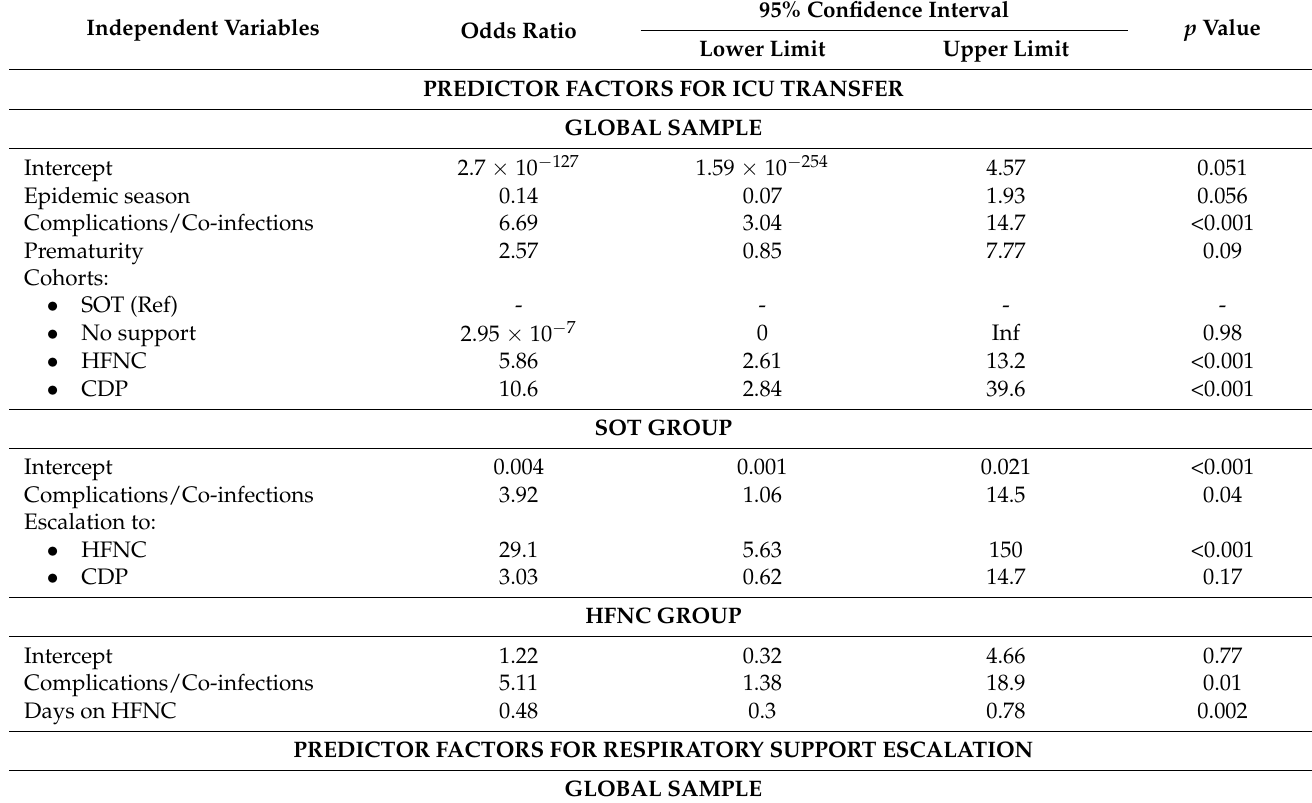
Table 2. Predictive multivariate LR model for ICU transfer and respiratory support